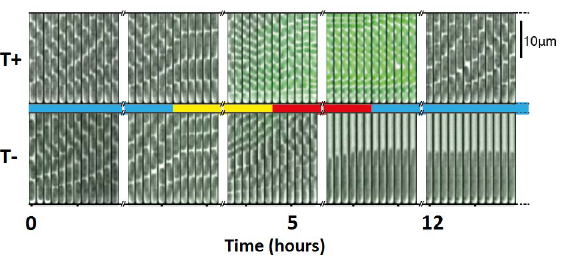
Figure 1. Bugs in tubes. A 13-hour time-lapse montage of images from the microfluidics device used for this study. The bottom of each tube is closed so that as bugs divide they move up the tube and are shed at the top. The blue bar in the middle indicates normal medium, the yellow bar indicates the use of depleted medium to induce the choice between T + and T 2 phenotype, and the red bar indicates the challenge with the antibiotic ciprofloxacin. In the top row of images, the cell at the bottom of the tube has a T + phenotype, as indicated by the green fluorescent protein reporter, and survives the antibiotic. In the bottom row, the corresponding cell is T 2 and perishes.